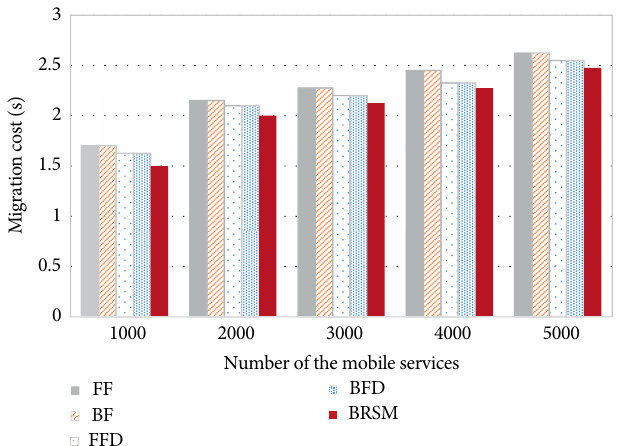
Figure 9: Comparison of migration cost by FF, BF, FFD, BFD and